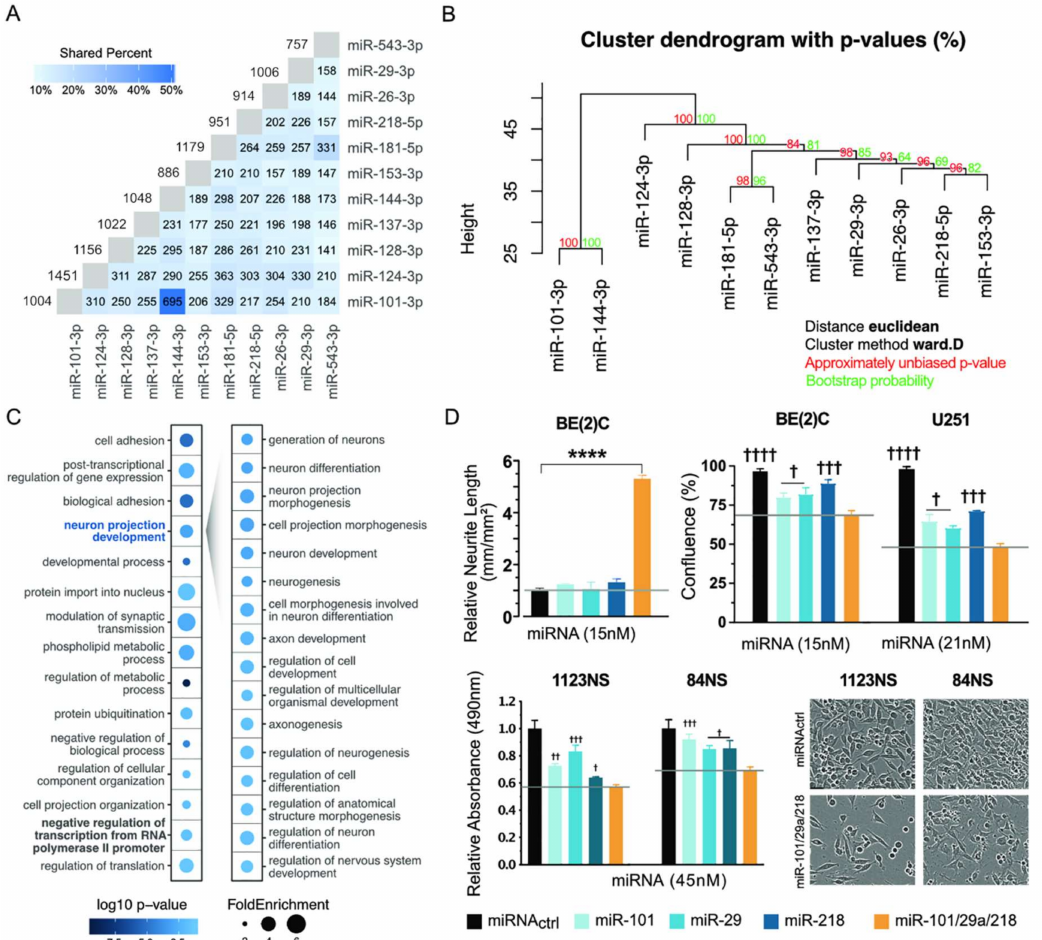
Figure 8. Associated tumor suppressor miRNAs offer other choices of combination treatment. ( A , B ) Identified tumor suppressor miRNAs showing strong target overlap according to TargetScan predictions [52]. Numbers indicate overlapping targets and the percentage of overlap is indicated by shading. ( C ) Gene Ontology analysis according to PANTHER [32] shows enriched biological processes for genes predicted to be targeted by at least five of the miRNAs listed in ( A ). ( D ) BE(2)C, U251, 1123NS, and 84NS cells were transfected with the same molecular amount of single miRNA mimics (control, miR-101, miR-29, or miR-218) or combination of three miRNAs. First bar graph: Effect of miRNA transfection (single vs. combination) on BE(2)C cell differentiation at 120 h; neurite outgrowth was used as parameter of neuronal differentiation. Second, third, and fourth bar graphs: Effect of miRNA transfection (single vs. combination) on cell proliferation at 120 h. One-way ANOVA with Tukey test for multiple comparisons was used to analyze results of all experiments. p -values for comparisons against miRNA combination: † p < 0.05; †† p < 0.01; ††† p < 0.001; †††† p < 0.0001; **** p <